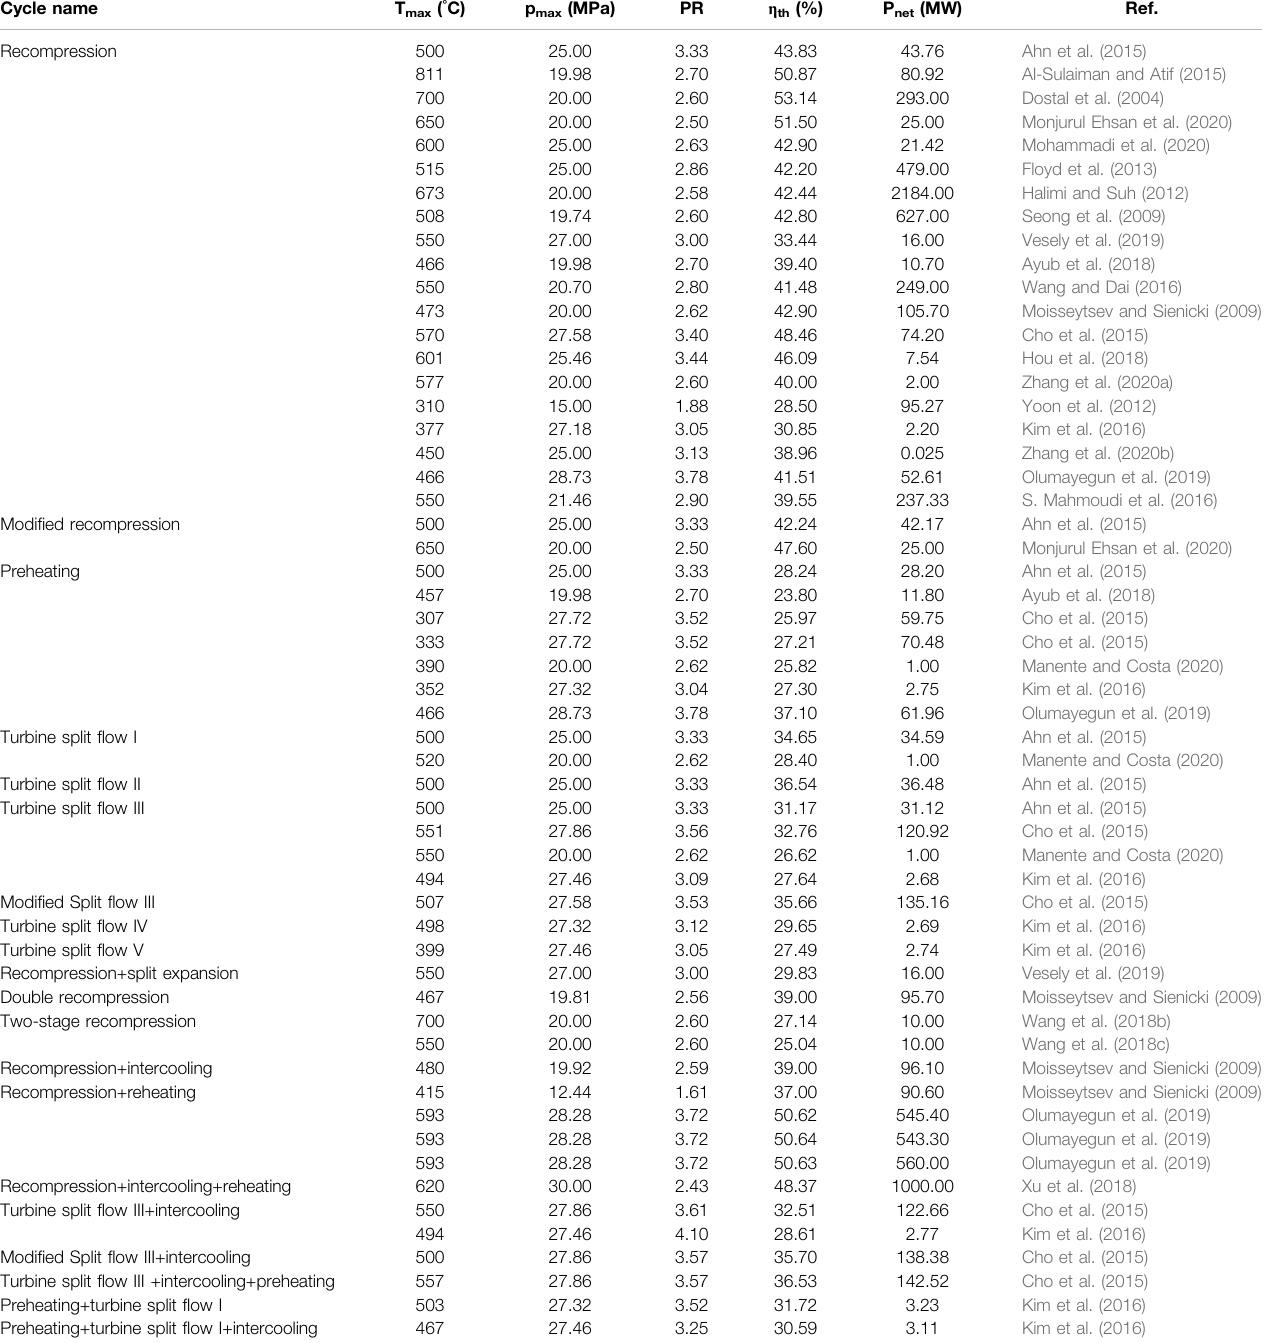
TABLE 3 | Boundary conditions of sCO 2 cycles with split- fl ow